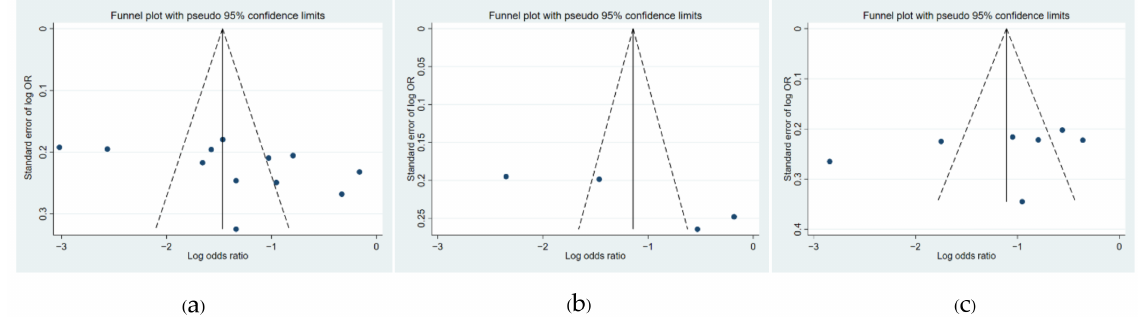
Figure 5. Funnel plot; ( a ) organophosphates; ( b ) carbamates; ( c )